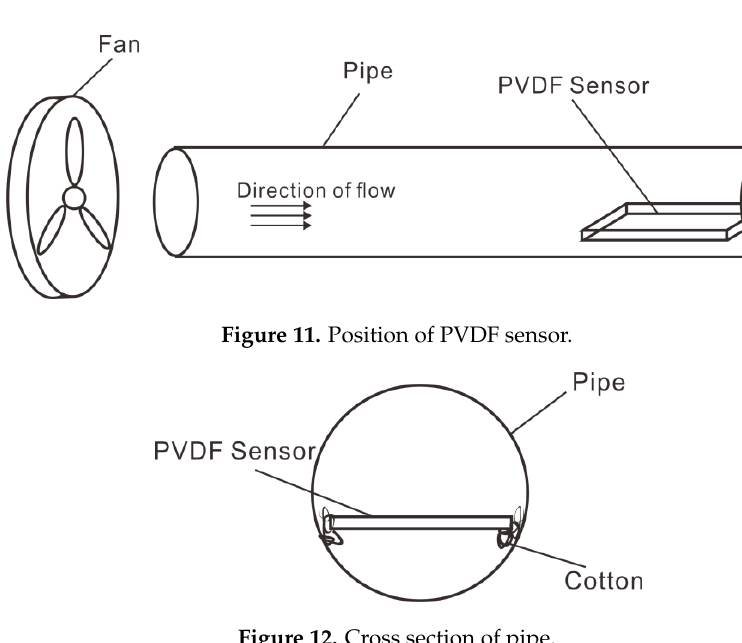
Figure 10. Experimental setup.